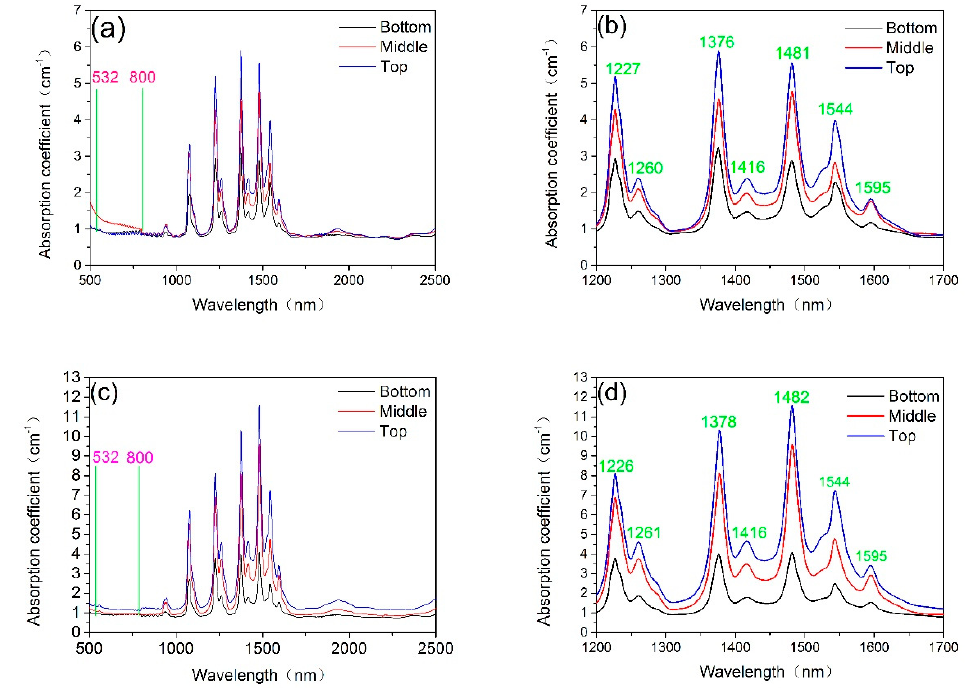
Figure 5. The absorption spectra of Sm:LGN crystals: ( a ) and ( b ) La 0.9 Sm 0.1 GN; ( c ) and ( d ) La 0.8 Sm 0.2 GN.